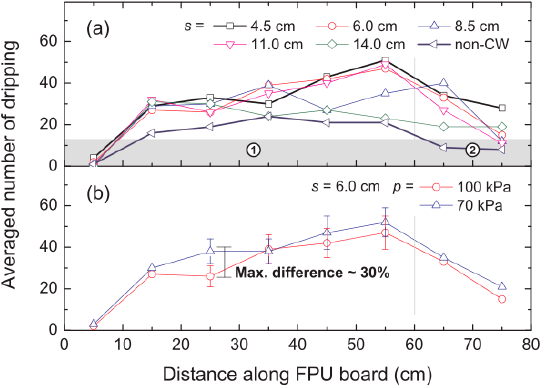
Figure 9. Averaged number of fuel drop drips in each section of 10 cm with ( a ) increased spacing and ( b ) various pressures [2].